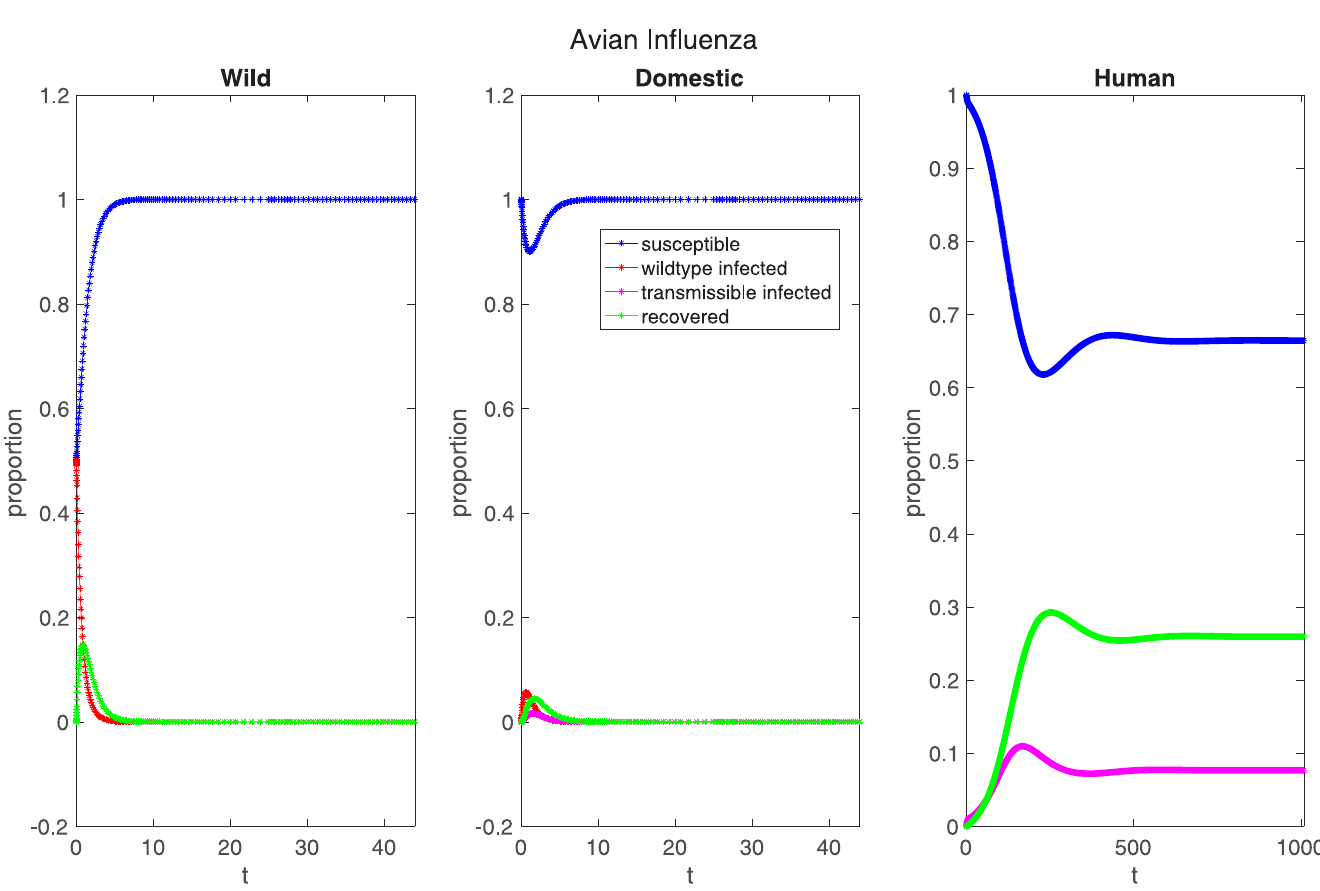
Fig 2. A simulation of low-pathogenic avian influenza mutating to high-pathogenic avian influenza. Parameters are as shown in Table 5. While the epidemic dies out in the animal species, its R 0 is 2.0871, allowing an epidemic to persist in humans.